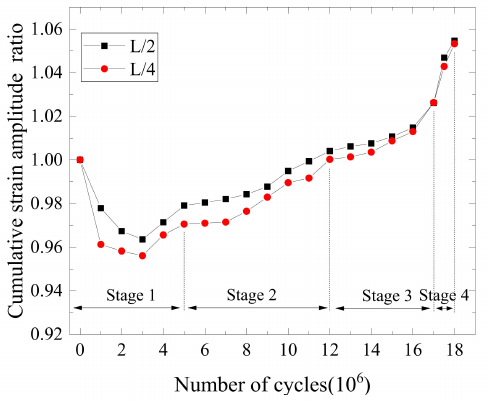
Figure 5. The cumulative evolution of the strain amplitude